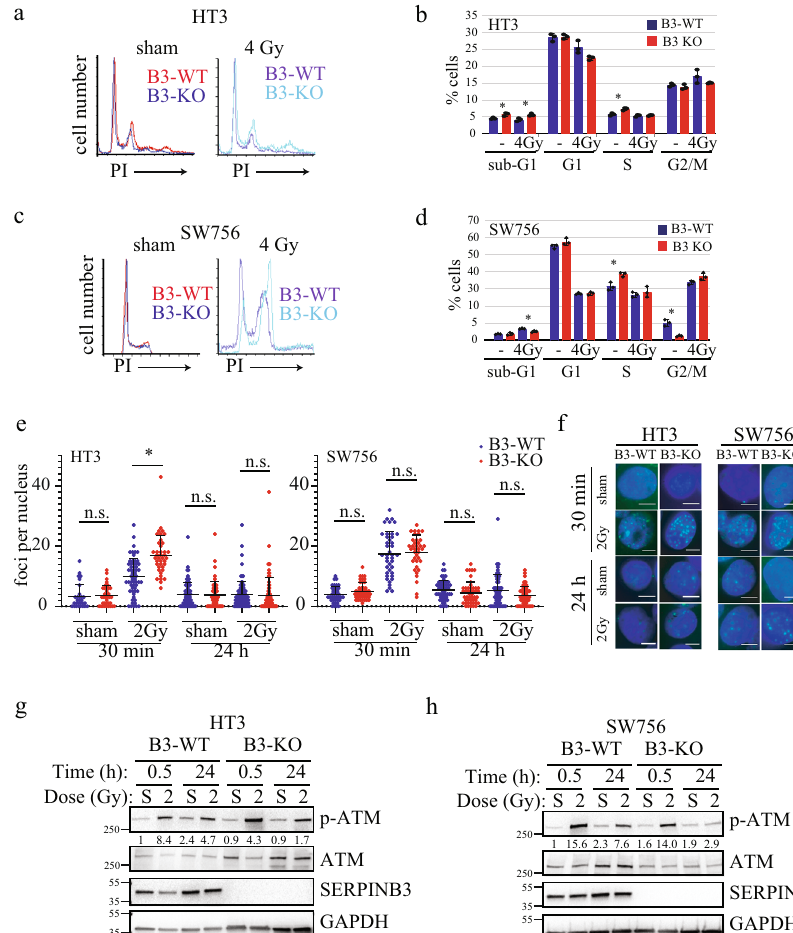
Fig. 3 Increased B3-KO cell death is not explained by cell cycle distribution or impaired DNA-damage repair. a , c Representative histograms for DNA content determined by propidium iodide staining and fl ow cytometry analysis of HT3 ( a ) or SW756 ( c ) cells, with PI intensity on the x -axis. b , c Mean and standard deviation quanti fi ed cell cycle distribution for triplicate repeats of HT3 ( b ) and SW756 ( d ) experiments. Individual data points are shown, and asterisks indicate students t -test p -value < 0.05. e ɣ H2AX foci per nucleus in HT3- and SW756-B3-WT and -B3-KO cells 30 min or 24 h after treatment with sham or 2 Gy. Dots represent individual nuclei, with mean and S.D. overlay. N.s. not signi fi cant, * = p < 0.05. f Representative nuclei shown for each condition with Hoechst 33342 (blue) and ɣ H2AX (green) merge. White scale bars shown. g , h Western blot analysis of total cell lysates from HT3- and SW756-B3-WT and – B3-KO cells 30 min and 24 h after treatment with sham (S) or 2 Gy radiation. Band intensity of p-ATM normalized to band intensity of GAPDH is displayed under p-ATM